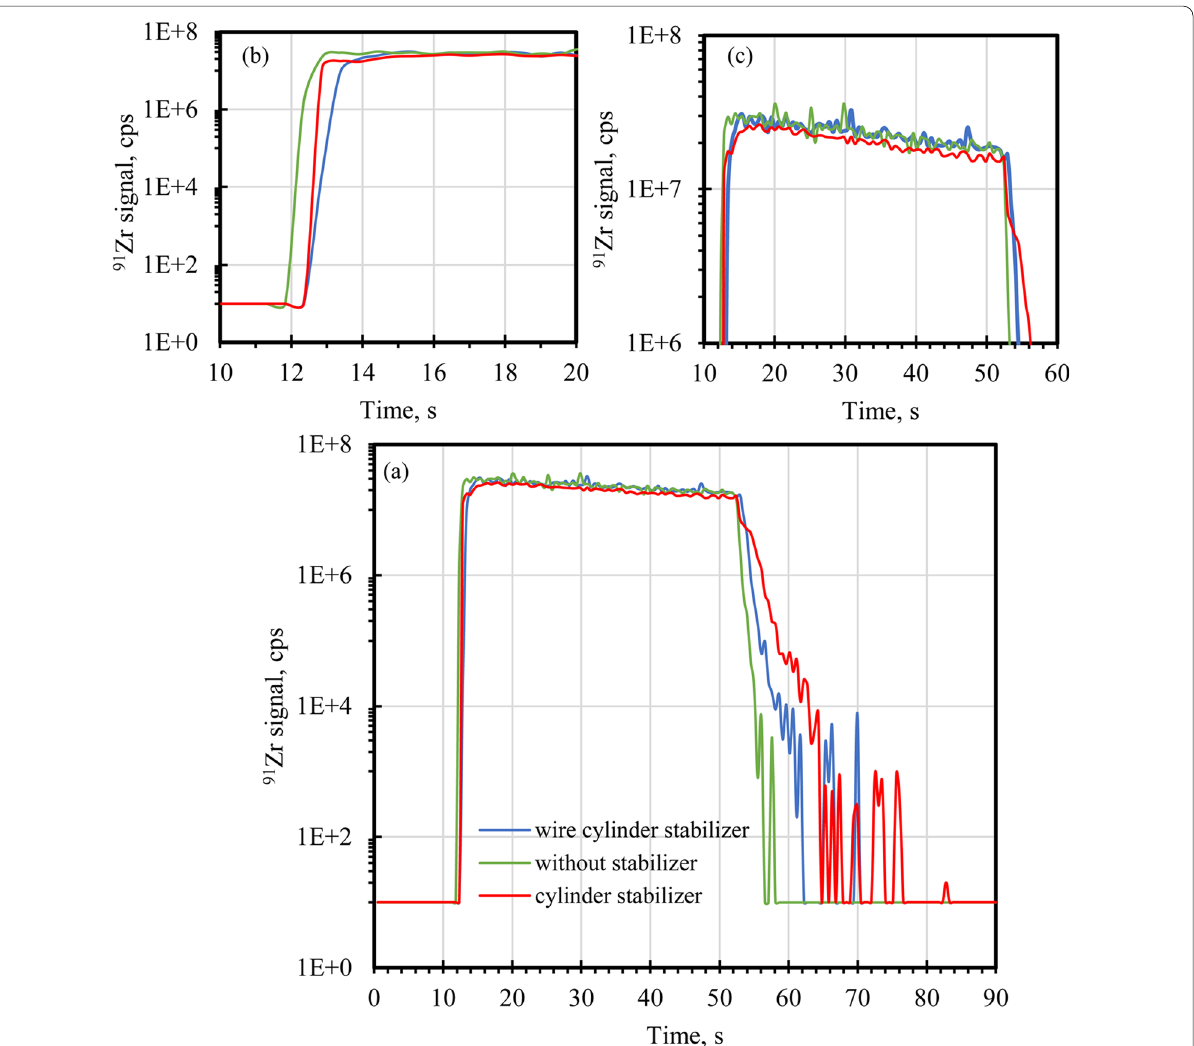
Fig. 4 Transient signal profiles of 91 Zr intensity of zircon standard 91500 with 35 μm of spot size and 5 Hz of laser repetition rate without stabilizer, with 21.2 mL of cylinder stabilizer and “wire” cylinder stabilizer. a Presented the signal profiles of 91 Zr versus assay time, while b , c Showed the corresponding signal rising and washout curves. Here, the “wire” cylinder stabilizer was assembled by packing 1.0 g of stainless wire into a 21.2 mL of cylinder